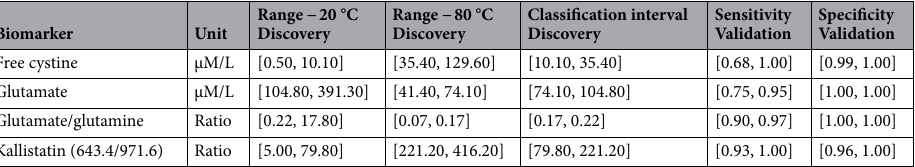
Table 4. Ranges of candidate biomarkers in the discovery set samples stored at − 20 °C and − 80 °C. Classification interval is the interval which gives perfect classification results in the discovery set. Sensitivity and specificity ranges are given in the validation set when the classification threshold is in the perfect classification interval.